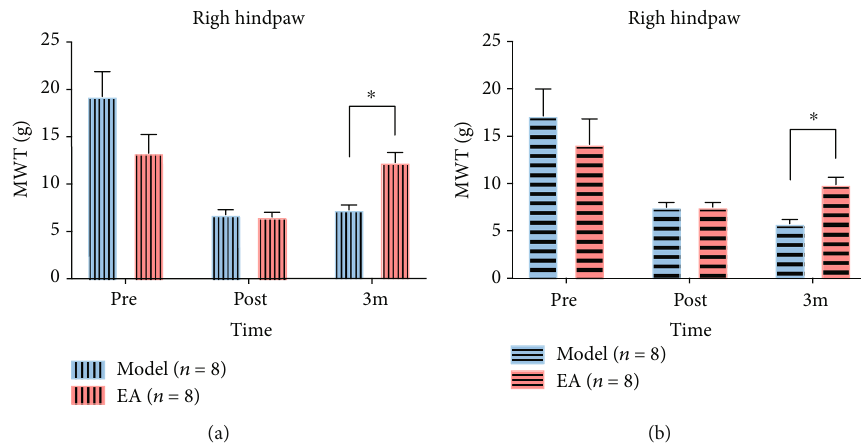
Figure 2: Result of mechanical withdraw threshold (MWT) between the model and EA groups. (a) Results of MWT between groups on the right hindpaw. (b) Results of MWT between groups on the left hindpaw. ∗ p < 0 : 05 (at individual time points between the model and EA